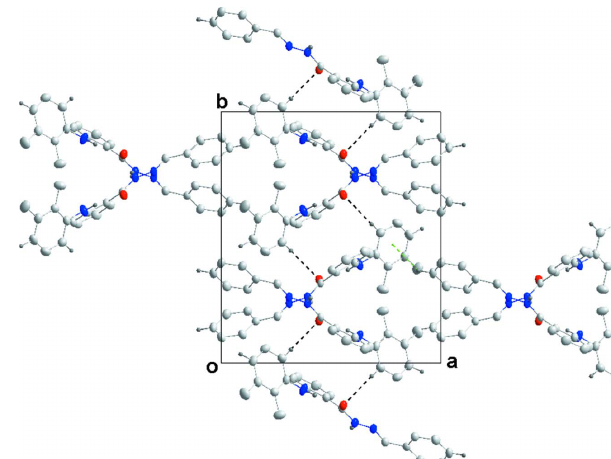
Figure 4 Packing view of (I) along the c axis with intermolecular C—H (cid:2)(cid:2)(cid:2) O hydrogen bonds shown as dashed lines.